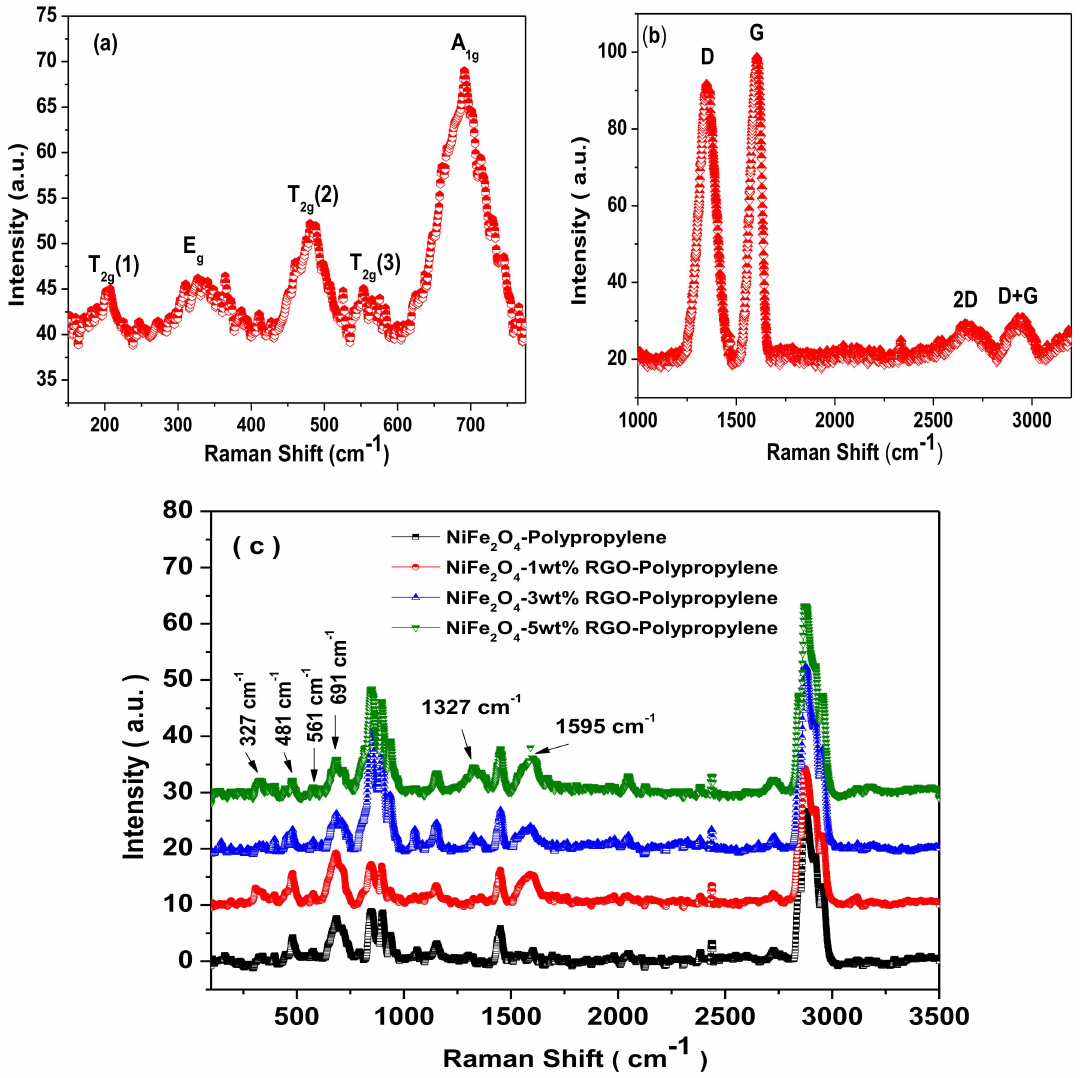
Figure 7. Raman spectra of ( a ) NiFe 2 O 4 nanoparticles, ( b ) Graphene Oxide, and ( c ) Polypropylene nanocomposites with NiFe 2 O 4 nanoparticles and in-situ reduced graphene